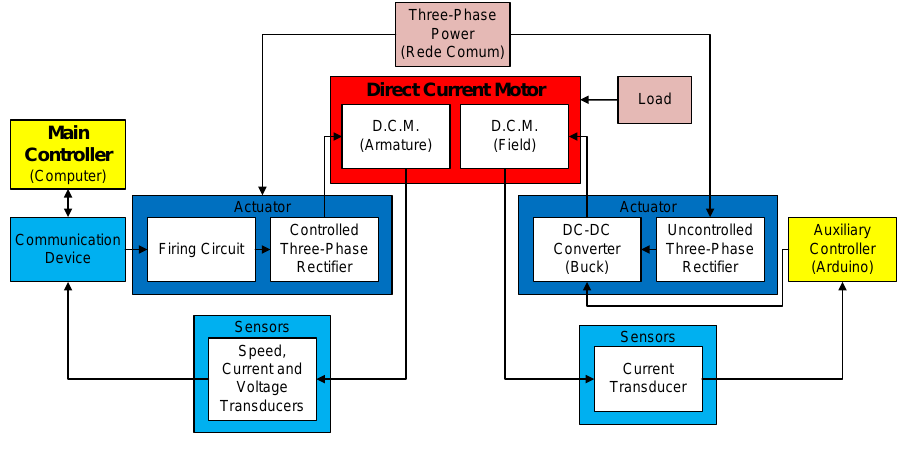
Figure 3. Model for the proposed real